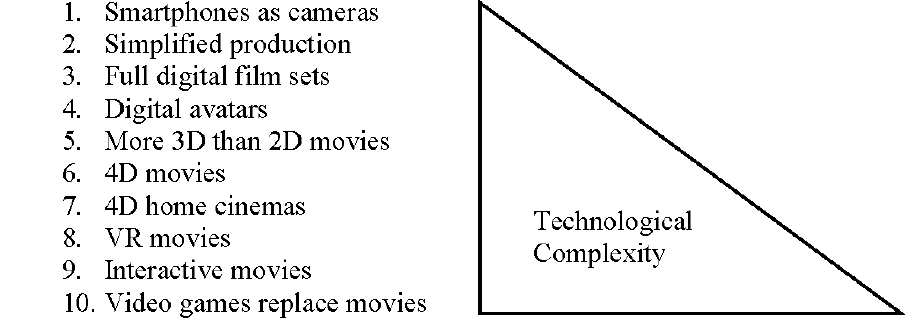
Figure 1. Overview of the projections. Source: own elaboration.